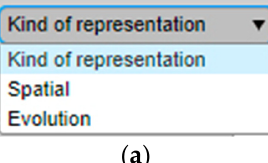
Figure 13. Drop down to select, ( a ) The type of representation, ( b ) the time for the spatial representation.